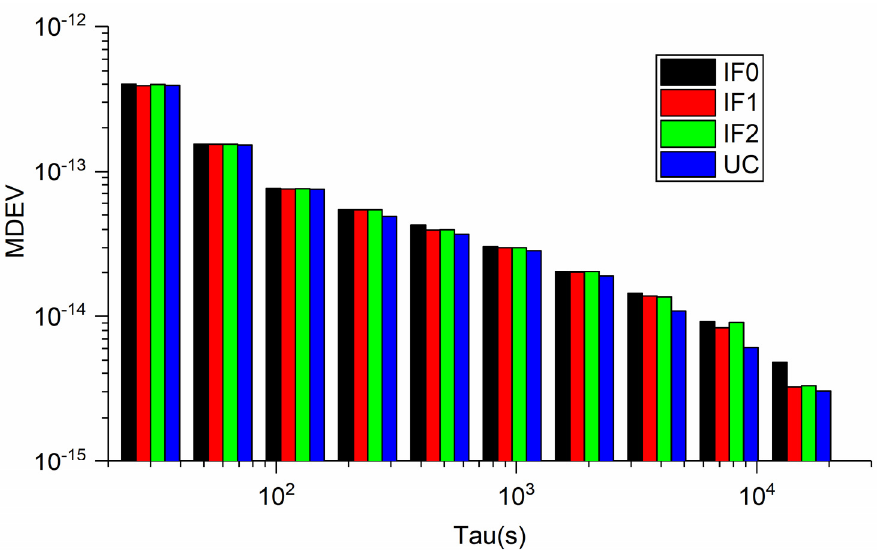
Figure 13. Comparison of MDEV between different Galileo PPP models for BRUX-PT11 on DOY 277, 2019.